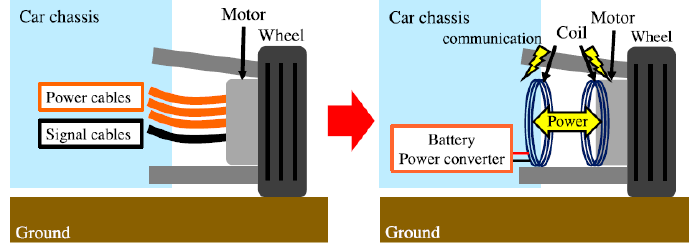
Figure 1. Comparison between classical wired and wireless interior wheel motor (IWM) [8].